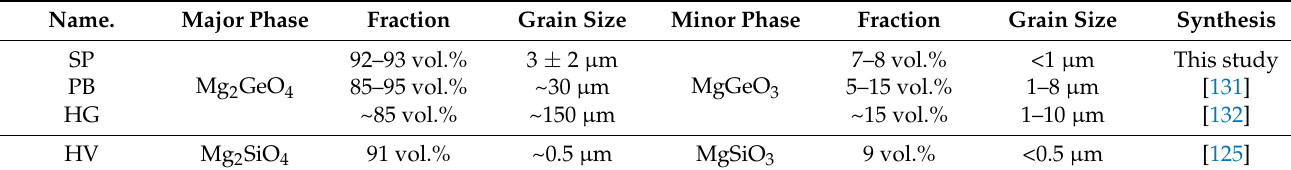
Figure 4. Starting material (SP-307): micrometric Mg 2 GeO 4 with minor MgGeO 3 (enstatite analogue). Surface polished using micrometric diamond suspension and colloidal silica in the end. Thermal etching at 1020 °C during 30 min. ( a ) Scanning electron microscopy image (secondary electron imaging; SEI) of SP-307, synthetized using SPS and representative of the starting material for all our experiments on Mg 2 GeO 4 (Table S1); ( b ) Backscattered electron image of the same area, showing denser crystals in white, corresponding to MgGeO 3 ; ( c ) Closer view (SEI) showing grain growth due to thermal etching. The grain growth is significant at grain boundaries and also noticeable on well-polished grains, reflecting the diversity of crystal orientations. Additional SEM images of SP-307 (homogeneous) and SP-308 (with mixing defects) are presented in Figures S3 and S4, respectively. Table 1. Description of the samples used for the deformation experiments.